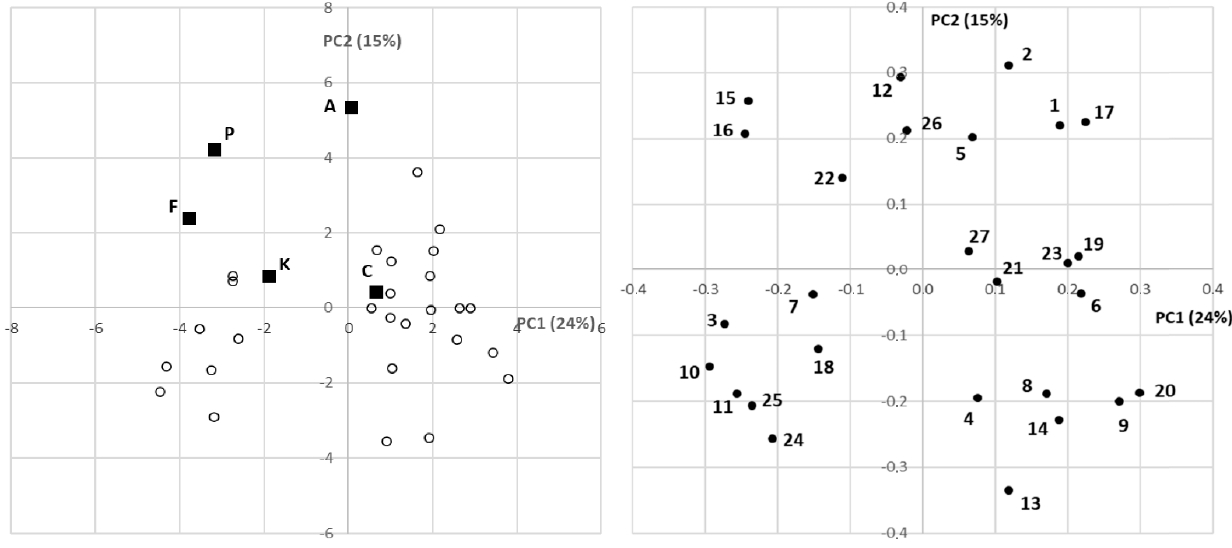
Figure 4. Score ( left ) and loading ( right ) plots from PCA. Meaning of letters in the score plot: female parent of the open pollination progeny, C; ”Arbequina” cultivar—A; “Frantoio” cultivar—F; “Koroneiki” cultivar—K; “Picual” cultivar—P. Meaning of numbers in the loading plot: 1—quinic acid; 2—maslinic acid; 3—oleuropein; 4—rutin (B); 5—oleanolic acid; 6—hydroxytyrosol glucoside; 7—